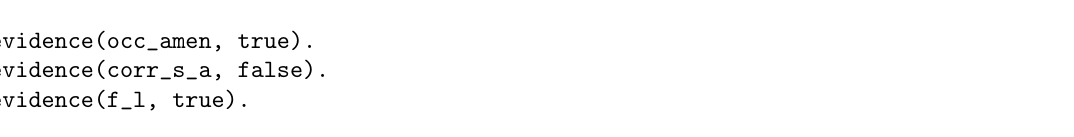
Listing 2. Example ProbLog encoding for